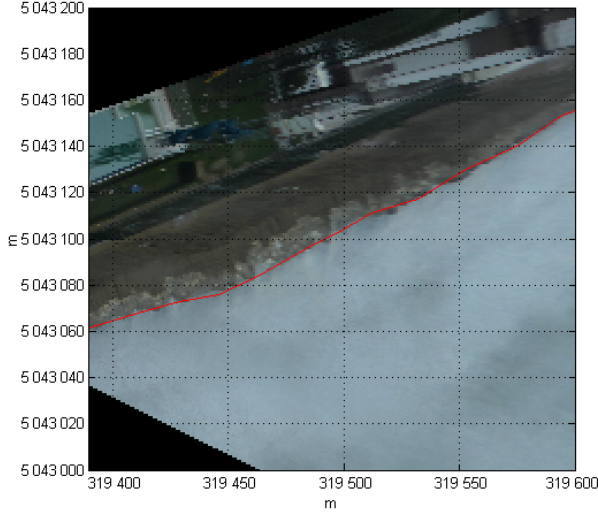
Figure 6. Shoreline detection on the rectified timex image during the 7th storm.